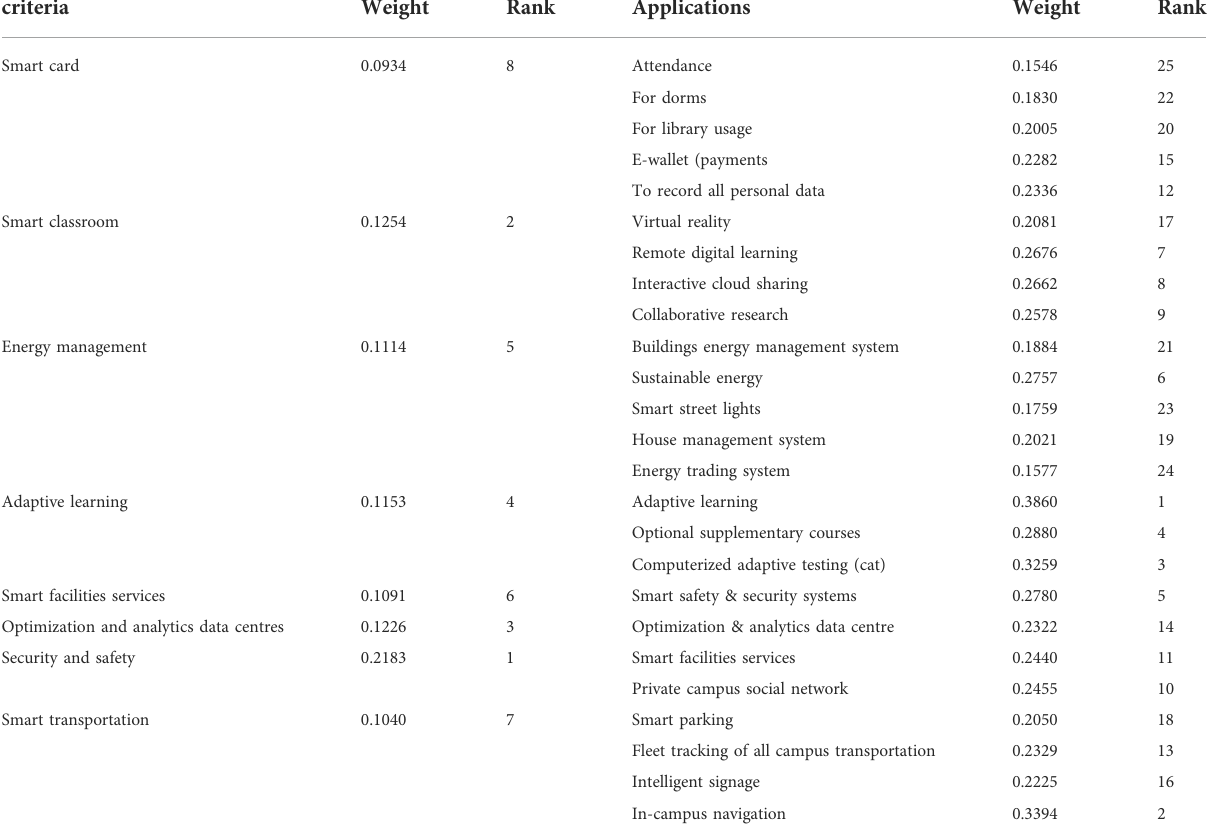
TABLE 6 IT support Personnel ’ s perception regarding signi fi cant smart campus criteria.